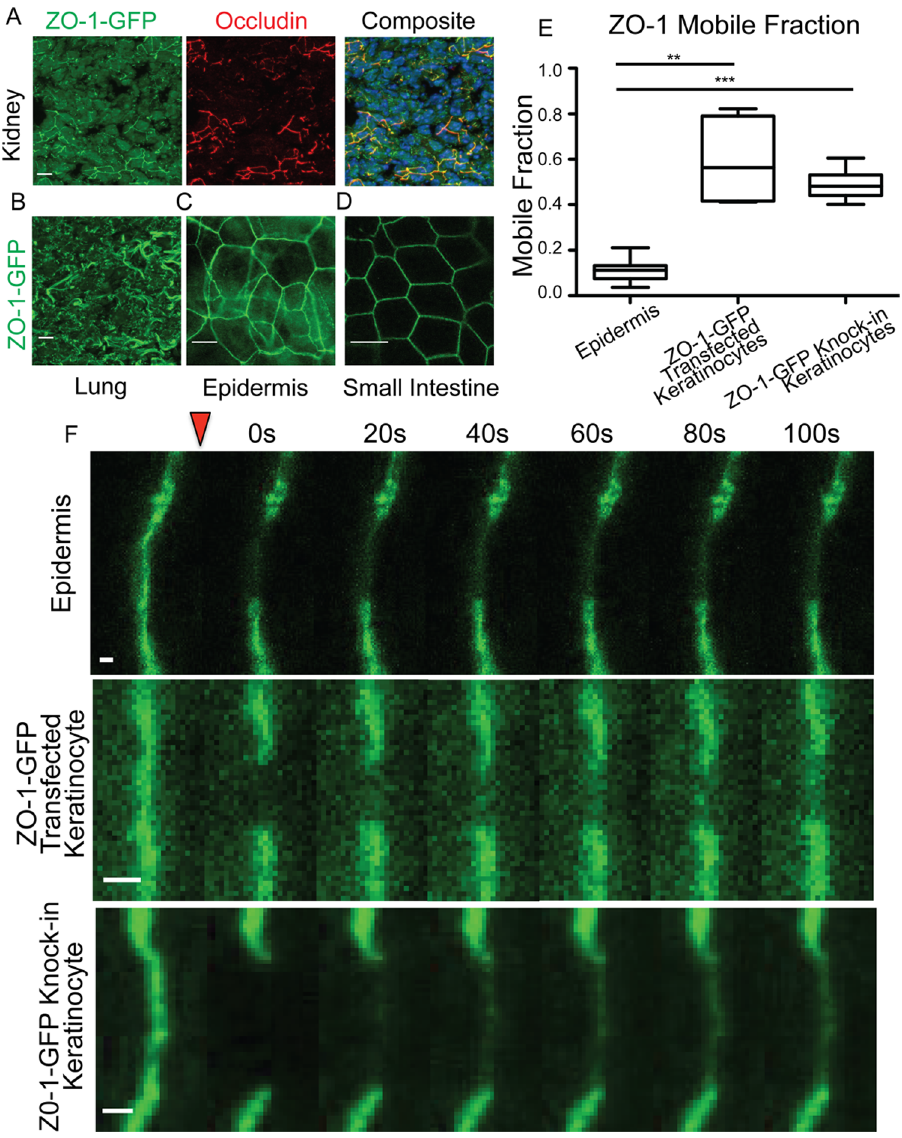
Figure 1. ZO-1 GFP exhibits low mobility in epidermis. A–D) Localization of ZO-1-GFP in skin sections taken from a ZO-1-GFP knock-in mouse. Scale bar 10 m m. A) ZO-1-GFP co-localizes with the tight junction protein occludin in kidney tissue sections of adult mouse. DNA is stained blue. B) Tissue section of lung taken from adult mouse. C) Whole mount epidermis of embryonic day 17.5 mouse. Note the ZO-1 signal in distinctive cobblestone pattern at cell-cell junctions in the granular layer. D) Whole mount small intestine taken from adult mouse. E) Mobile fractions from FRAP experiments are plotted. The box represents the 25 th to 75 th percentile and the whiskers represent the 10 th and 90 th percentiles. ** p , .005. *** p , .0001. F) Representative kymographs are shown of individual FRAP experiments. The bleach point is indicated by the red triangle. Scale bar 1 m